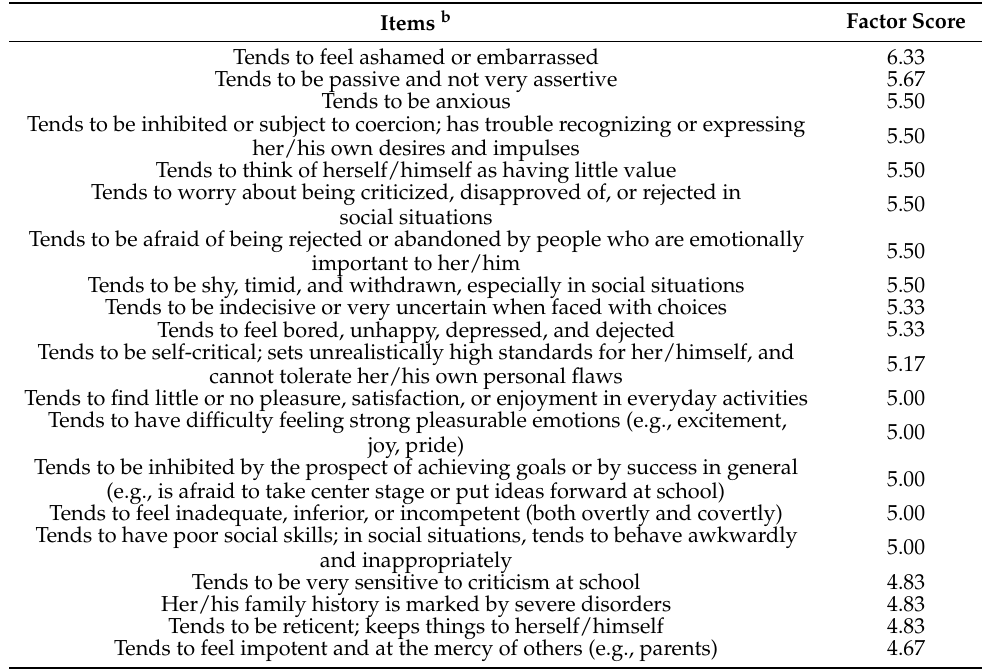
Table 5. Best CPAP-Q a items of the inhibited/self-critical prototype.